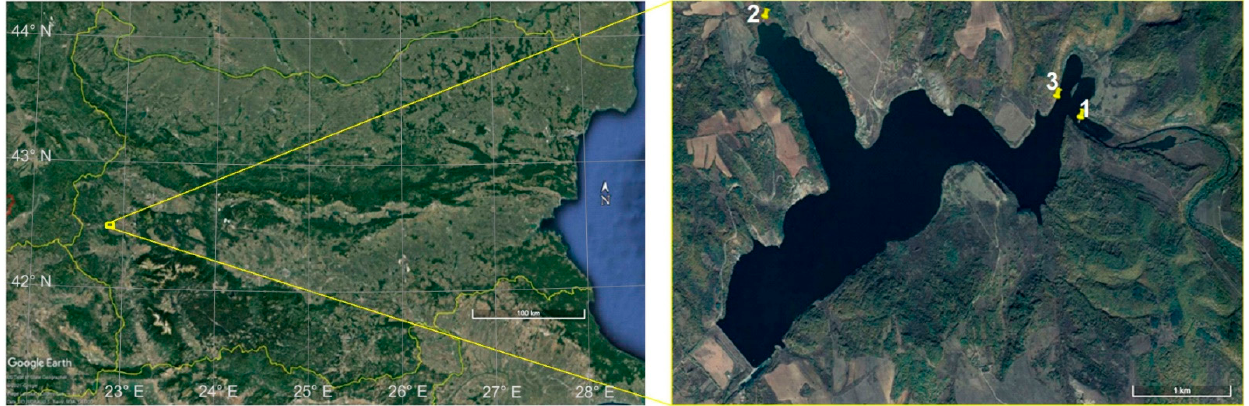
Figure 5. Sampling locations (1-Struma, 2-Svetlia and 3-Pchelina).